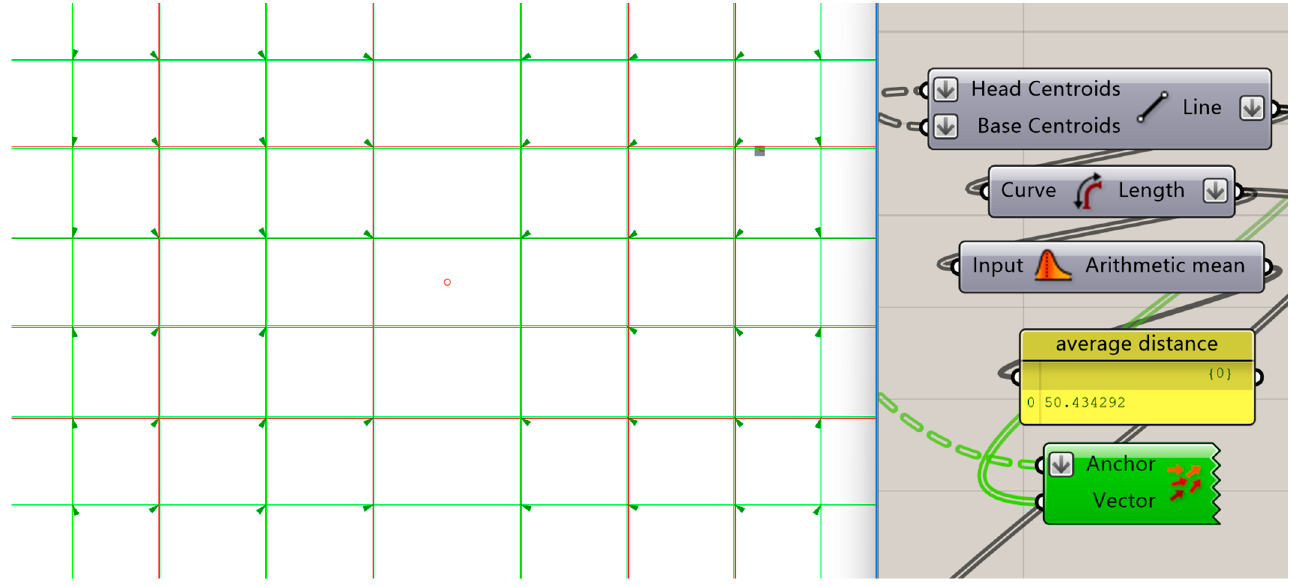
Figure 19. The inclination and the average distance.